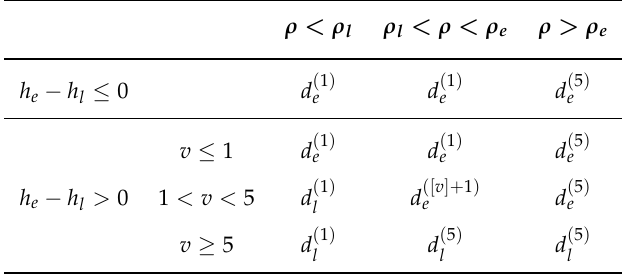
Table 2. Optimal solutions to Problem 1 for ρ (cid:54) = ρ l and ρ (cid:54) = ρ e .